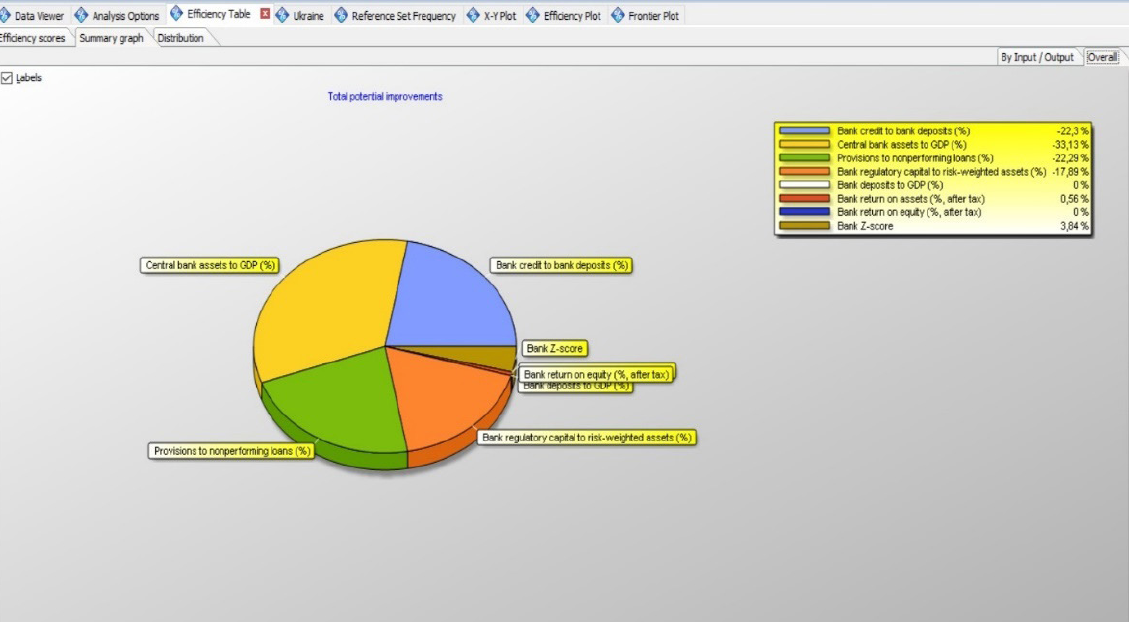
Figure 6. Potential for improving the efficiency of banking systems in 17 European countries and Ukraine as of 2020 for the DEA BCC